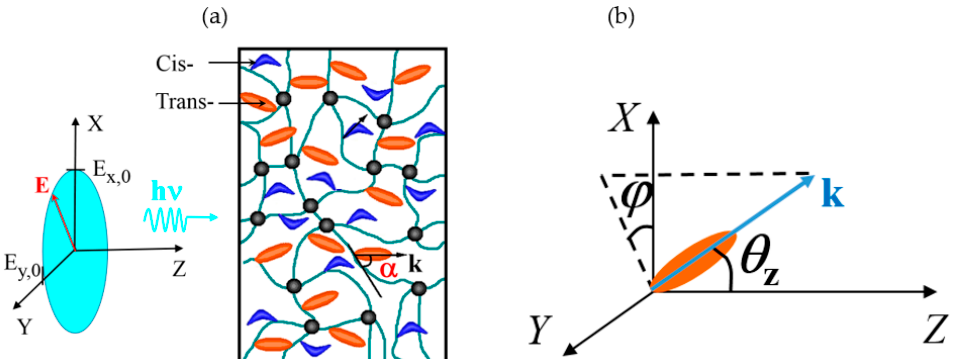
Figure 1. Model of an azobenzene-containing polymer network under irradiation with elliptically polarized light ( a ). Orientation of an azobenzene in the frame of references related to the elliptically polarized light ( b ). α is the angle built by the long axis of the chromophore denoted by a vector k and the Kuhn